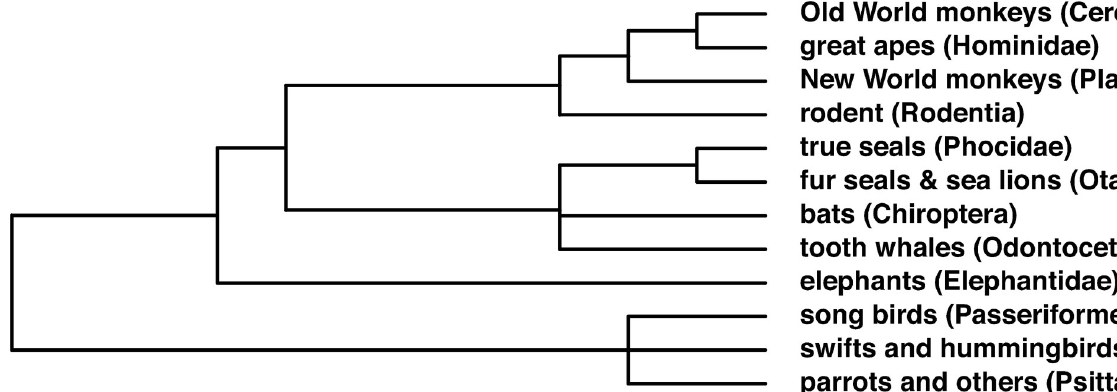
Fig 1. Tree of vocal learners with a focus on behavior. Differences between this tree and the canonical tree are reflected in the presence of primates and rodents. The inclusion of whole families or orders is made under the assumption that all members thereof are at least worth studying and is not a claim about their actual vocal learning abilities, which are an empirical question. Common and scientific names from NCBI (https://www.ncbi.nlm.nih.gov/taxonomy). Tree built with taxize R package [82]. NCBI, National Center for Biotechnology Information.